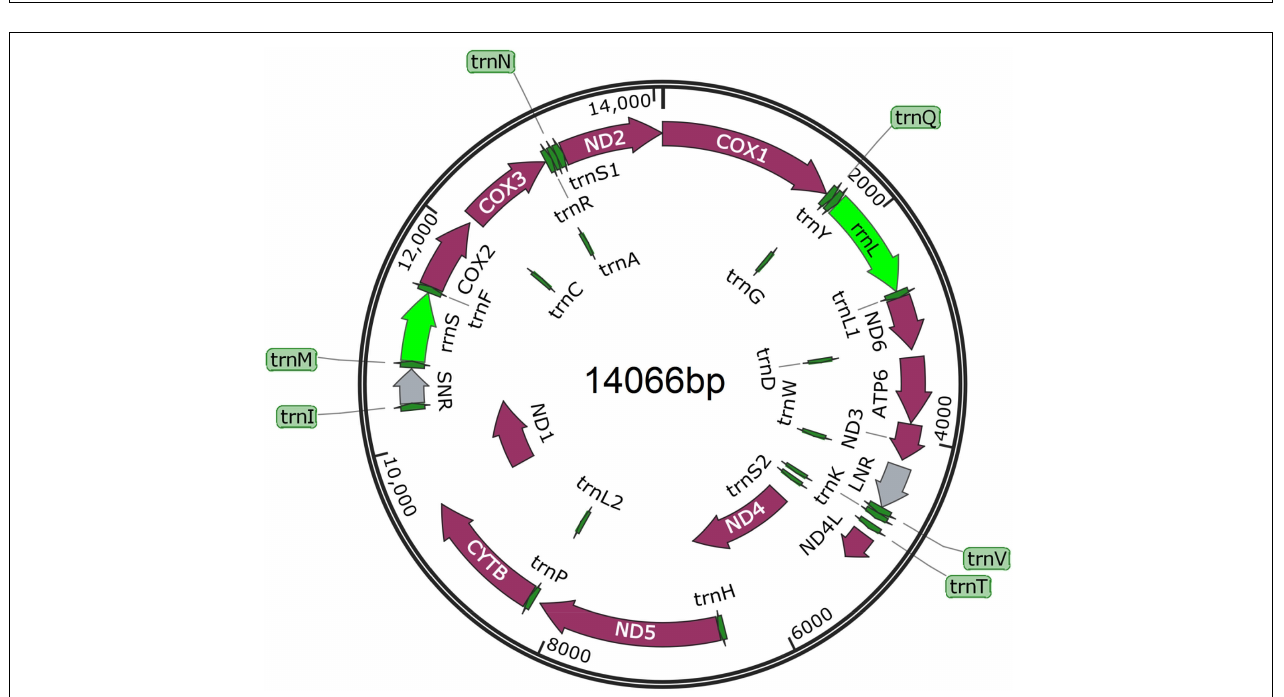
FIGURE 3 | Composition of the complete mitochondrial genome of Moniliformis sp. XH-2020. All genes are arranged clockwise with the names of the genes annotated. LNR and SNR represent long non-coding and short non-coding regions.